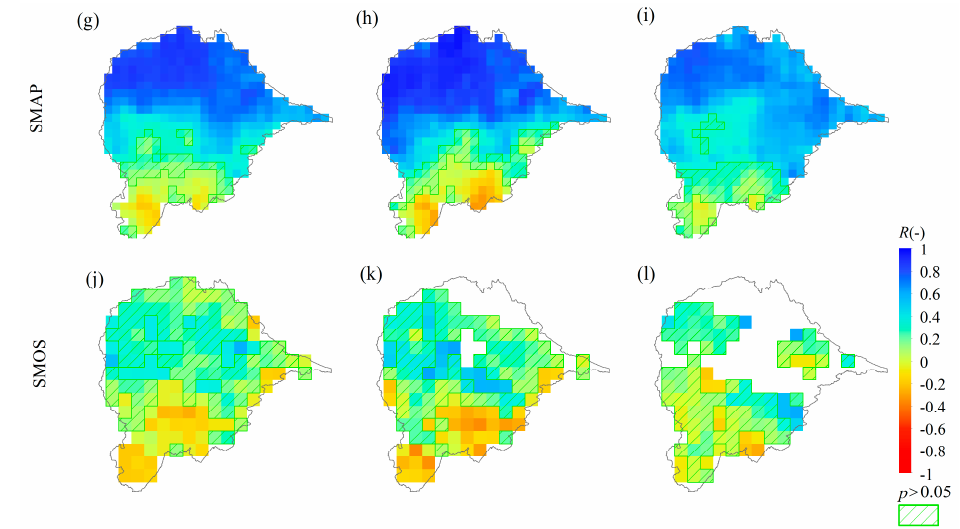
Figure 12. Correlation-coefficients between gridded SWI of each remotely sensed soil moisture product ( ω RS ) with DDRM model-simulated soil moisture ( ω DDRM ) across the Qujiang catchment for the whole period ( left column ), the dormant seasons ( middle column ) and the growing seasons ( right column ), respectively. Grids where p -value is above 0.05 are highlighted by green lines.